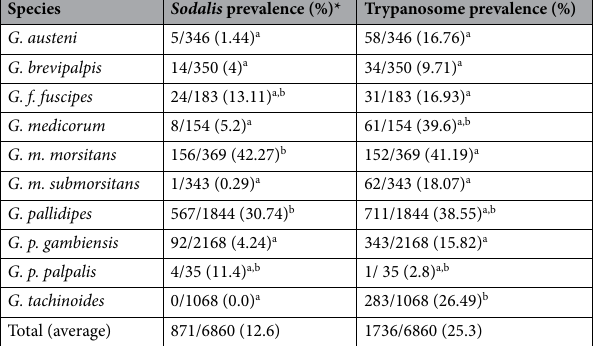
Table 2. Global prevalence of Sodalis and Trypanosomes in tsetse samples analyzed per tsetse species. * Values indicated by the same lower-case letter do not differ significantly at the 5% level.